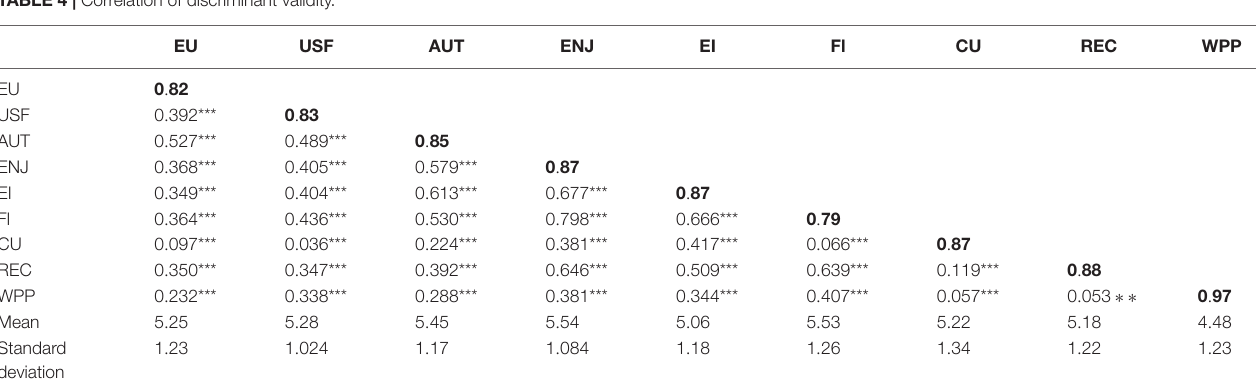
TABLE 4 | Correlation of discriminant validity.